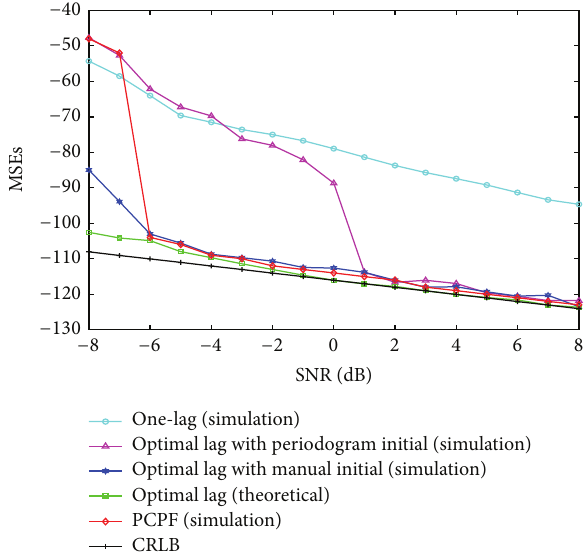
Figure 7: Plot of the simulated MSEs of the proposed iterative procedure with one-lag, optimal lag, PCPF, and